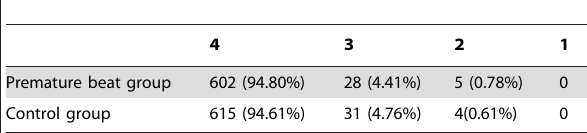
Table 4. Coronary artery image quality